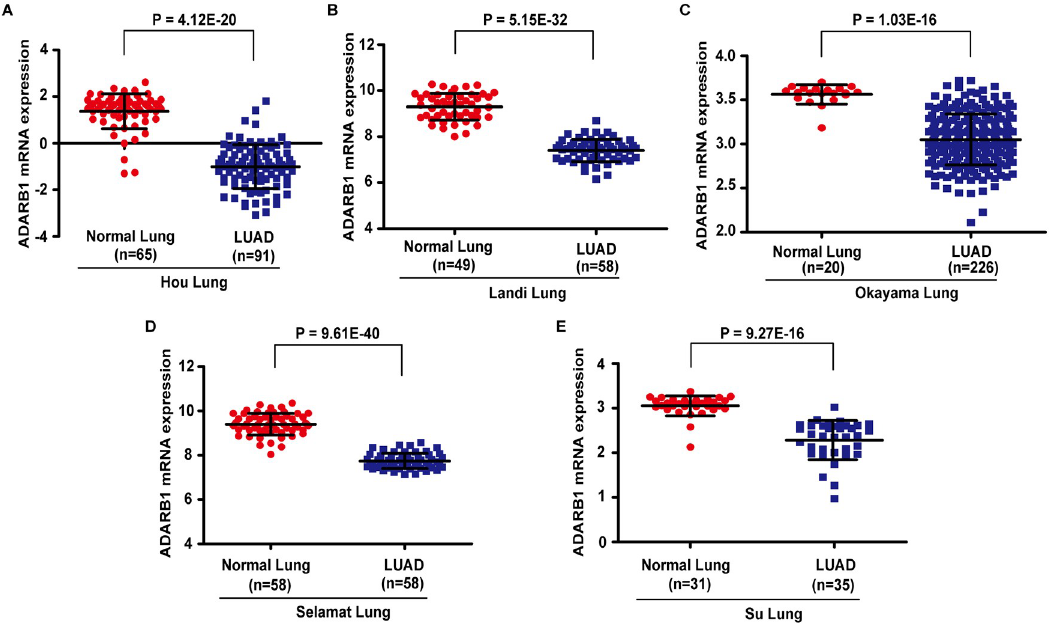
Fig 1. The Oncomine database indicated the downregulated ADARB1 in LUAD tissues. The expression of ADARB1 in five datasets (Hou Lung, Landi Lung, Okayama Lung, Selamat Lung and Su Lung) acquired from the Oncomine